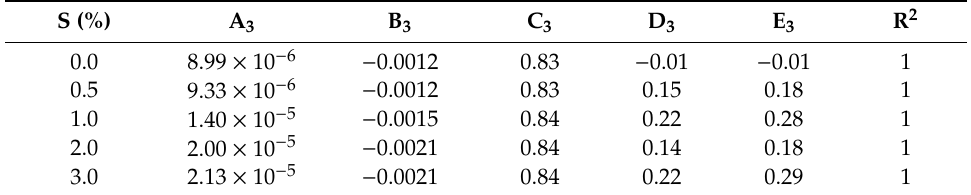
Figure 6. Variation of average R f of different confining pressure with FTCs. Table 8. Parameters of rational function that could reflect the relationship between R f and FTC under different S.